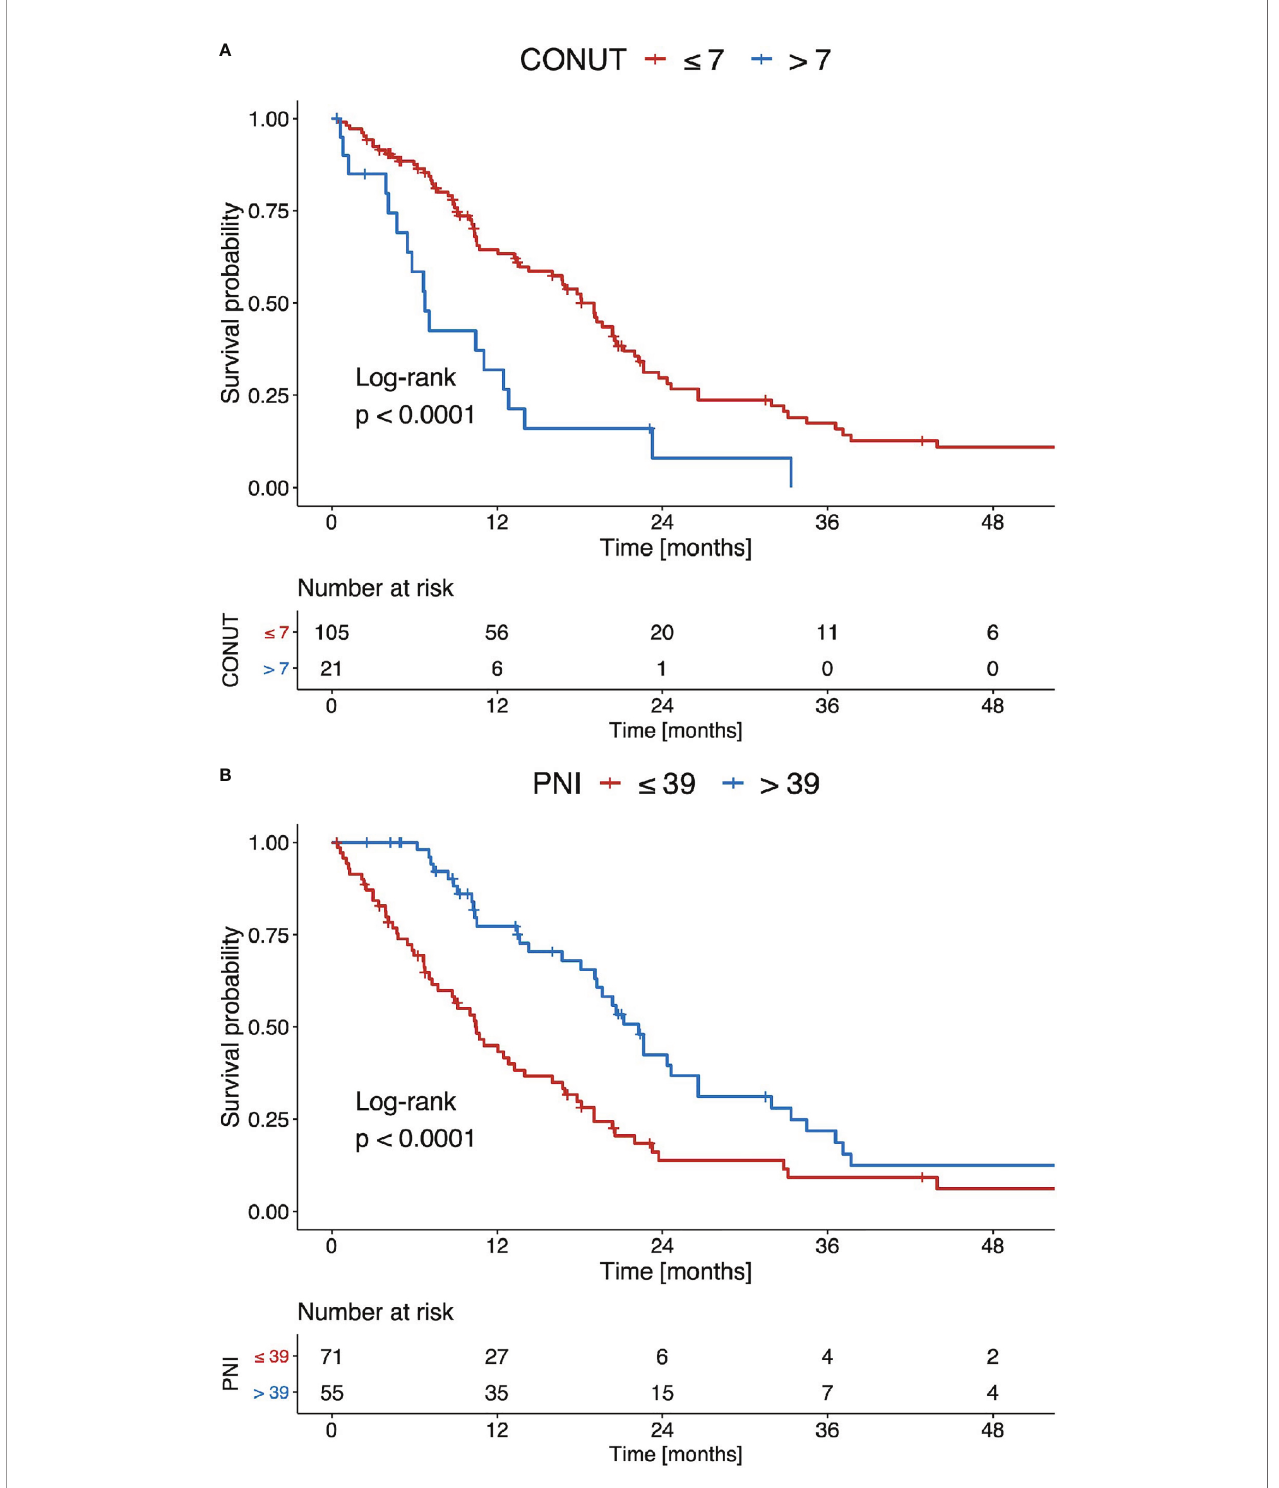
FIGURE 4 | Kaplan Meier curves of overall survival strati fi ed according to (A) the CONUT score and (B) the PNI for the recommended TACE candidates (BCLC